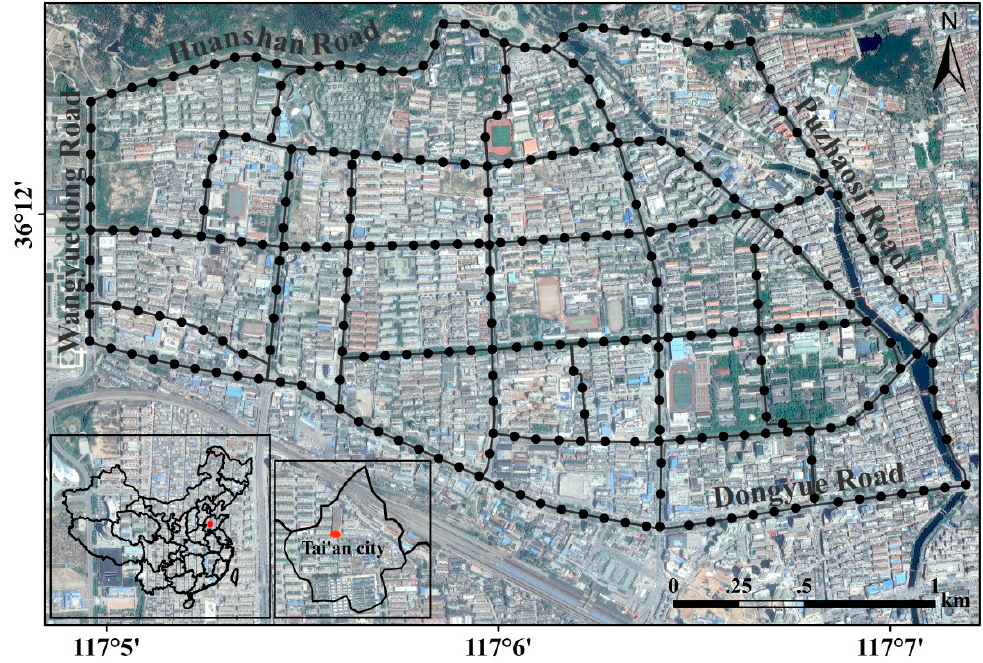
Figure 2. Location of the study area and randomly generated street sample sites.